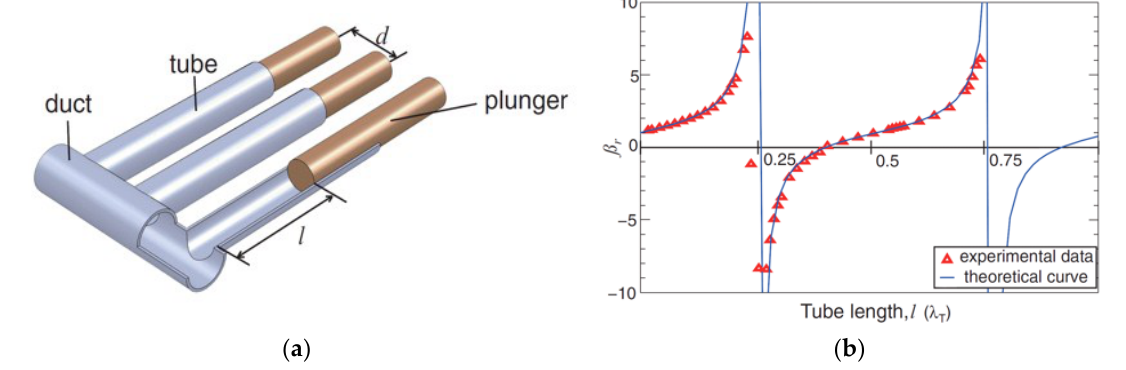
Figure 4. ( a ) AMM exhibits continuously tunable compressibility; ( b ) Theoretical curves and the experimental data for the effective compressibility β r of the duct as a function of the tube length l . Adapted with permission from [130], APS, 2012.